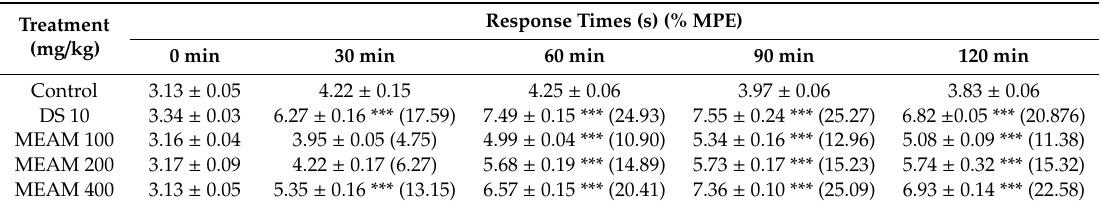
Table 4. Analgesic e ff ect of methanol extract of A. montanum (MEAM) and diclofenac sodium (DS) on tail immersion test in mice.